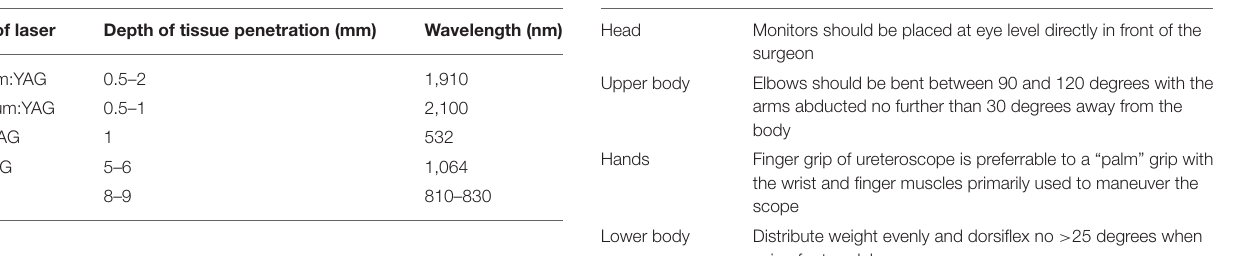
TABLE 2 | Ergonomic recommendations by body region (35,